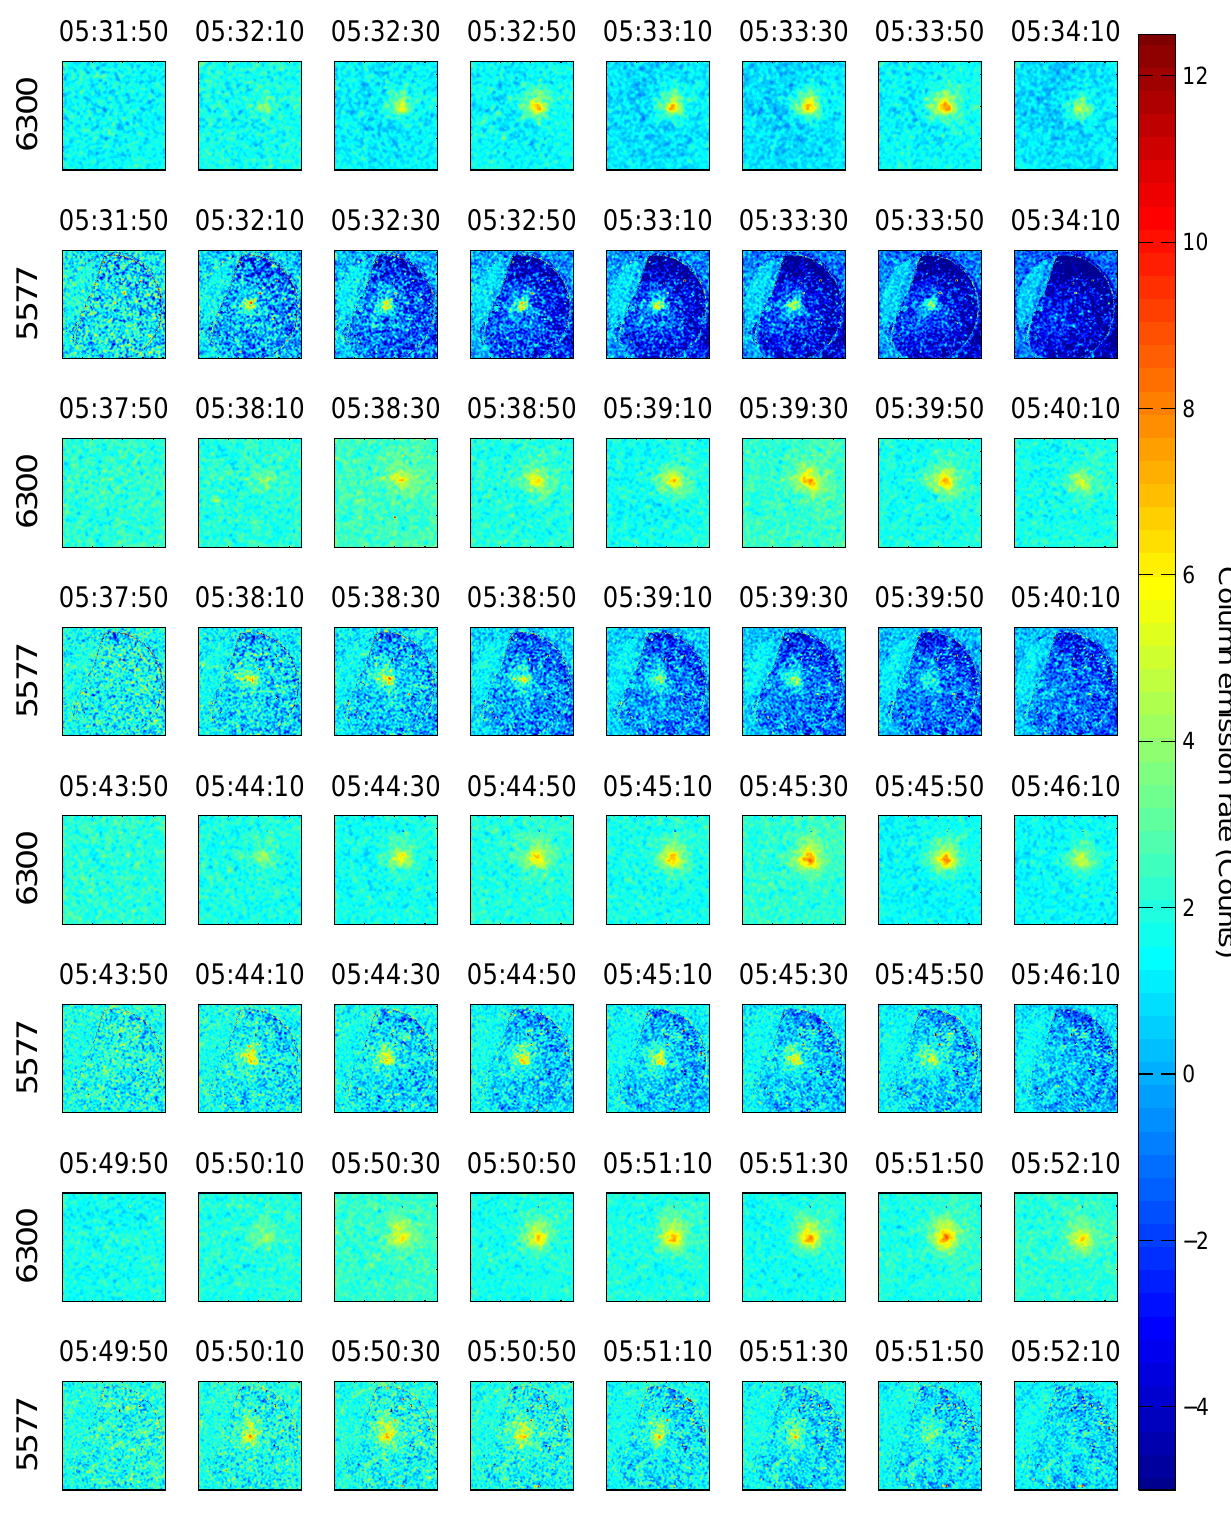
Fig. 3. Wide field-of-view ( ≈ 45 ◦ at 6300 ˚A, ≈ 75 ◦ at 5577 ˚A) optical observations from the HIPAS site show the gradual increase and decay of the enhanced emissions at 6300 ˚A and the instantaneous on-off characteristics (at the 7s exposure 10s inter-exposure time of the observations) at 5577 ˚A. Both emissions are presented in relative units. Time increments are 20s